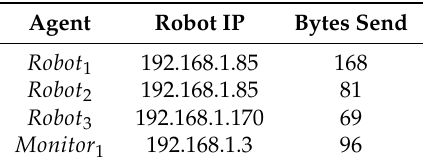
Table 9. Experiment with three robotic agents and one monitor